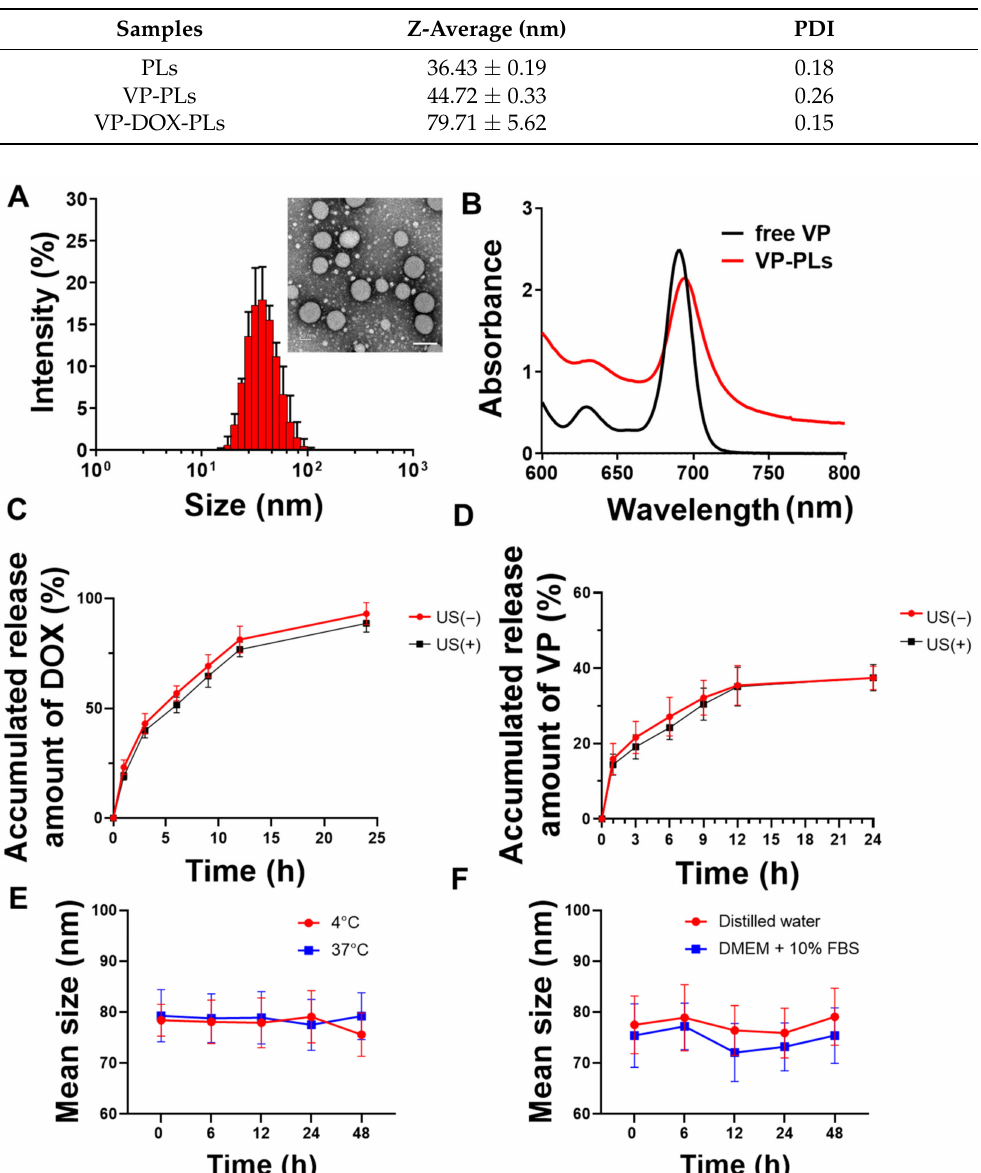
Figure 2. Characteristics of VP-DOX-PLs. ( A ) Size distribution and inset TEM image of VP-DOX-PLs. Scale bar indicates 100nm, ( B ) UV absorbance spectrum of free verteporfin (VP), and verteporfin loaded polymersomes (VP-PLs). ( C ) Doxorubicin and ( D ) verteporfin in vitro release profile from VP-DOX-PLs with and without ultrasound (US) irradiation. ( E ) In vitro stability of VP-DOX-PLs at (4 and 37) ◦ C in PBS and in ( F ) DW and DMEM + 10% FBS serum